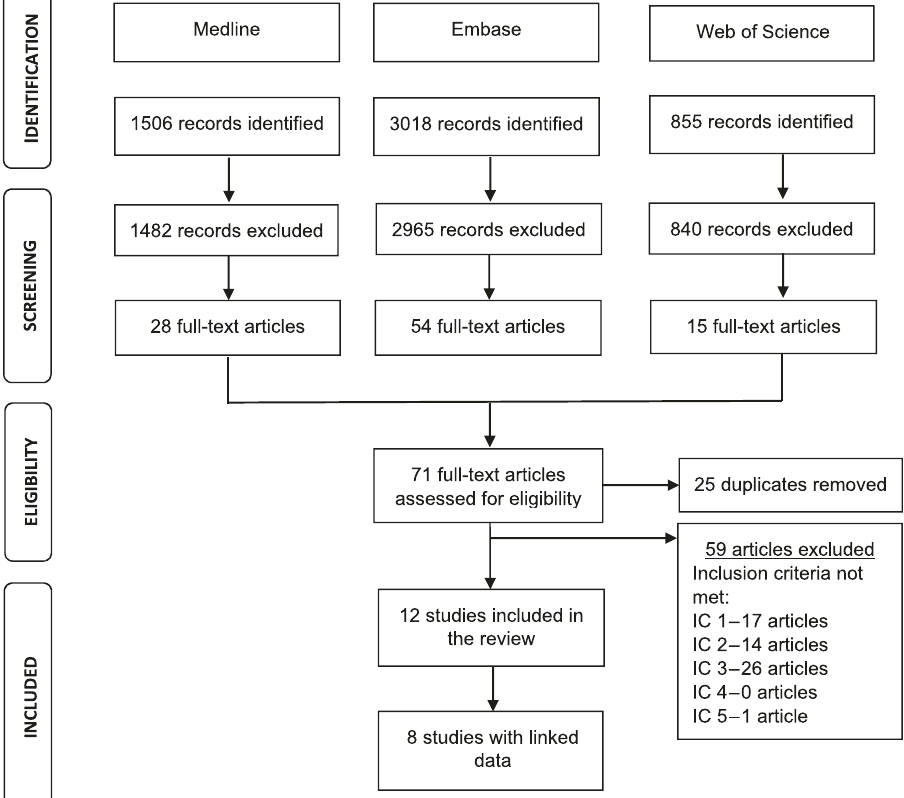
Fig. 1 Preferred Reporting Items for Systematic Reviews and Meta-Analyses (PRISMA) fl owchart for study selection. IC inclusion criteria, IC 1 routinely collected primary care records, IC 2 primary care asthma population, IC 3 varying severities of asthma identi fi ed. IC 4 full peer- reviewed article available. IC 5